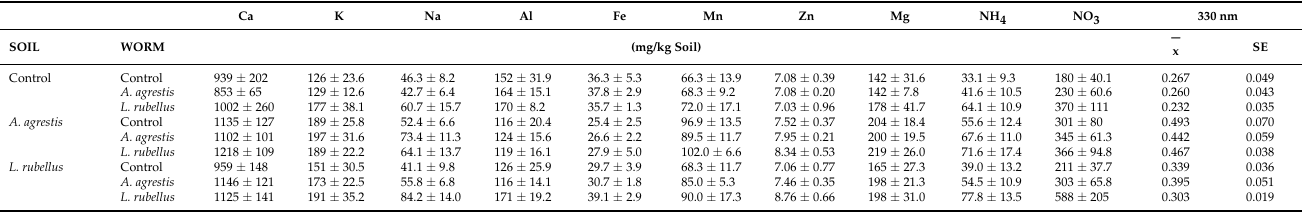
Table 2. Mean nutrient concentrations (mg/kg soil) of bulk soil after extraction with NH 4 Cl. Standard errors ( ± ) are also given. Only Fe and 330 nm absorbance were significantly different among SOIL